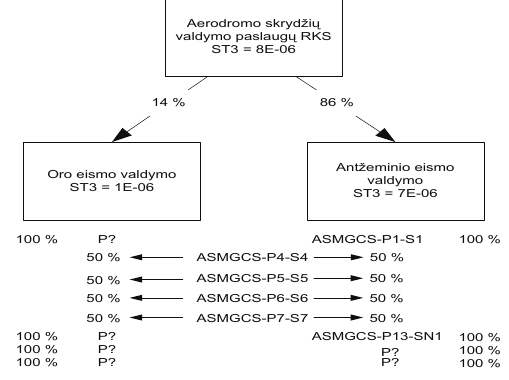
Fig. 4. Distribution of planed safety